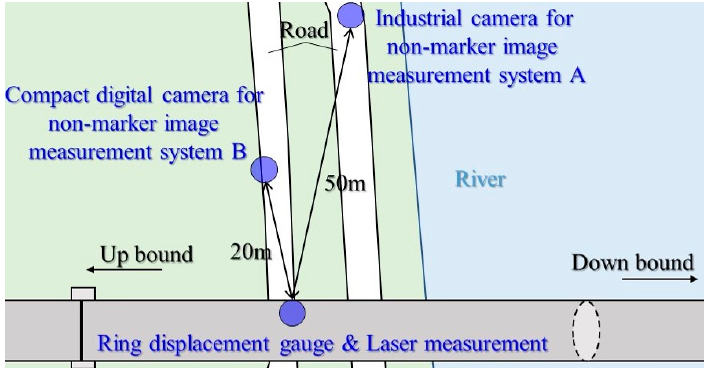
Figure 7. Installation status of each measuring device for bridge A.